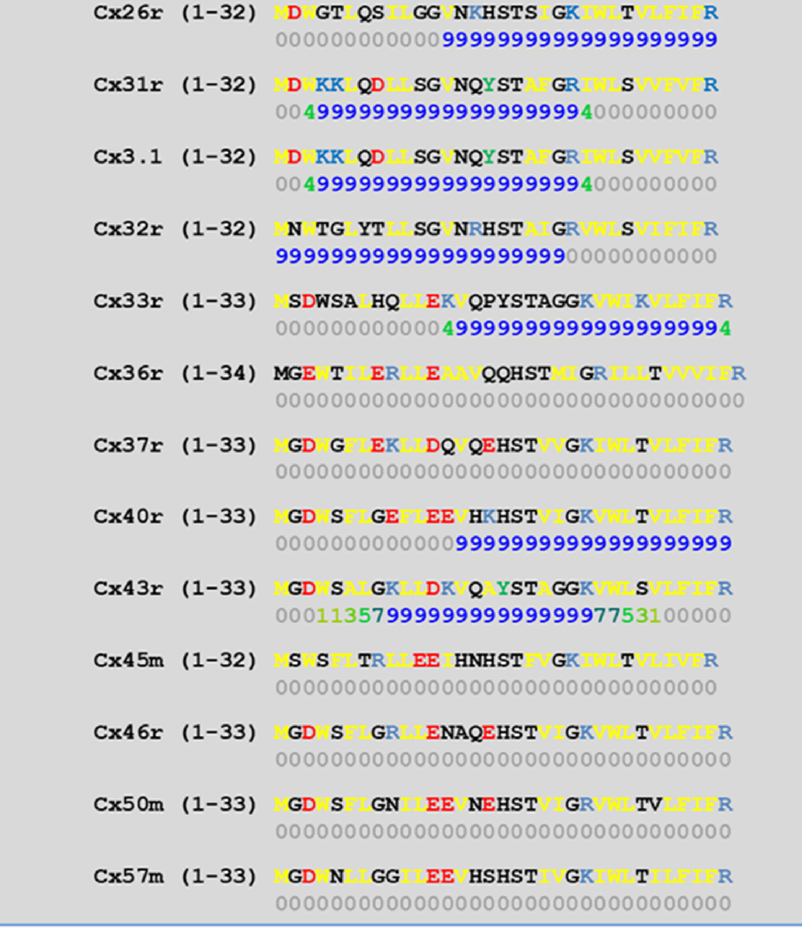
Figure 6. Predicted CaM-binding Site at CT1 Domain.